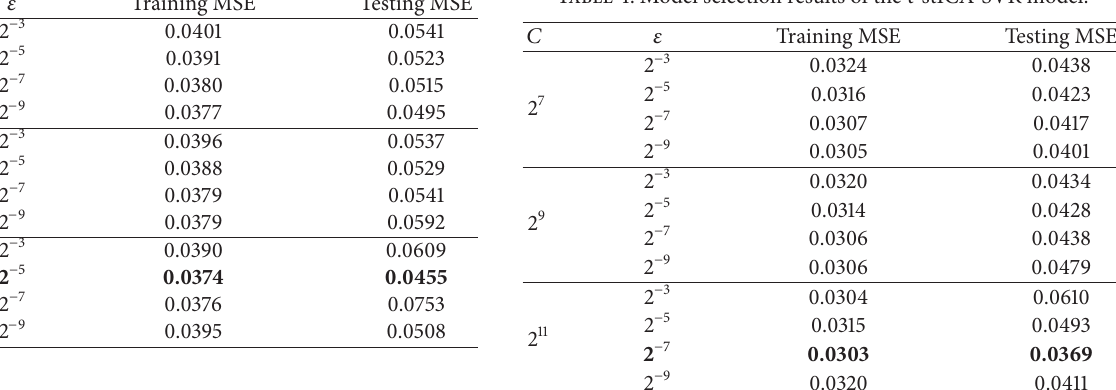
Table 4: Model selection results of the t-stICA-SVR model.